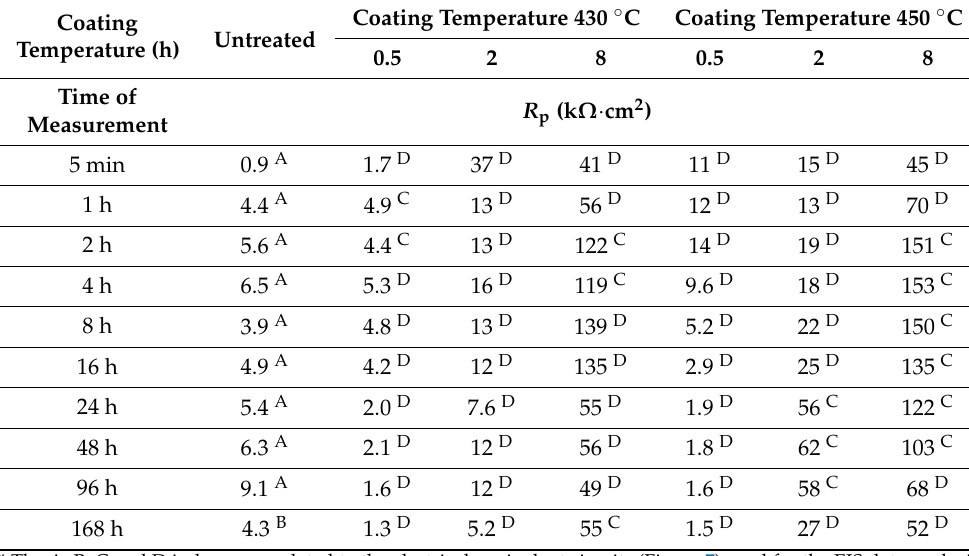
Table 4. Calculated values of polarization resistance, R p *, obtained from EIS measurements per- formed in SBF solutions at 37 ± 2 ◦